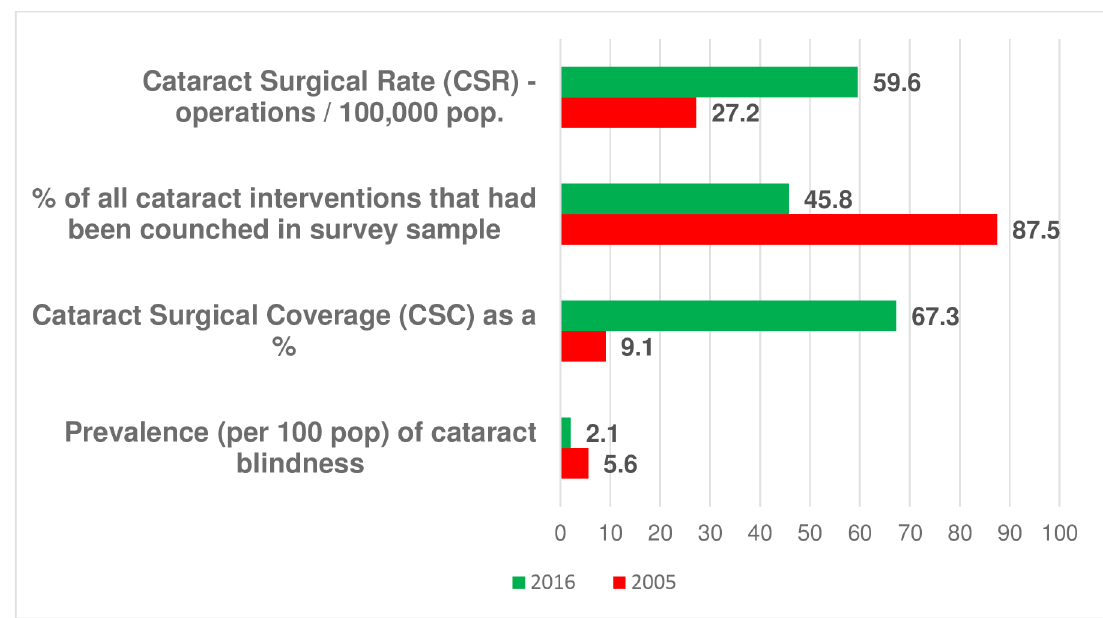
Fig 2. CataractServiceIndicators from the 2005 and 2016